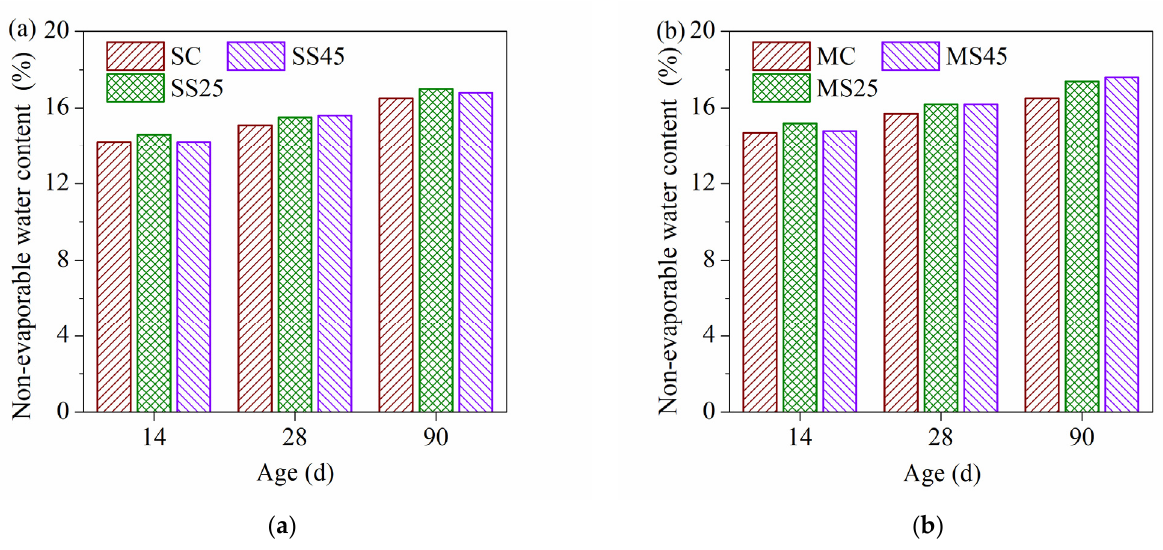
Figure 14. Non-evaporable water content of hardened pastes: ( a ) under standard curing conditions; ( b ) under temperature-matching curing conditions.